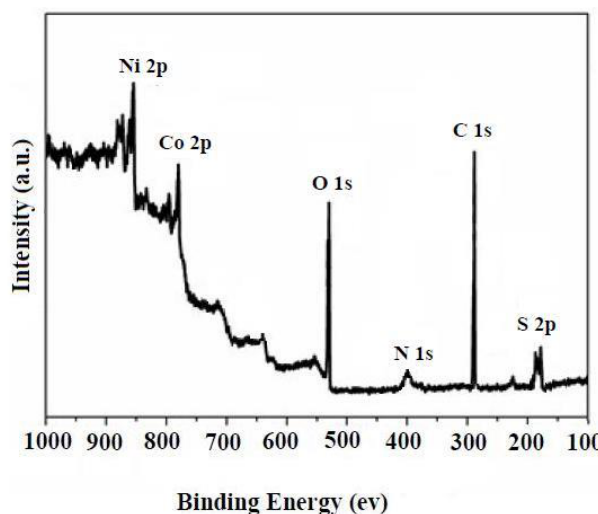
O /NiO@GQDs @SO 3 4